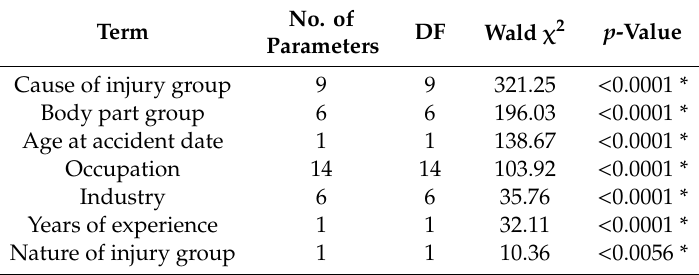
Table 3. Estimates from the logistic regression (LR) model.